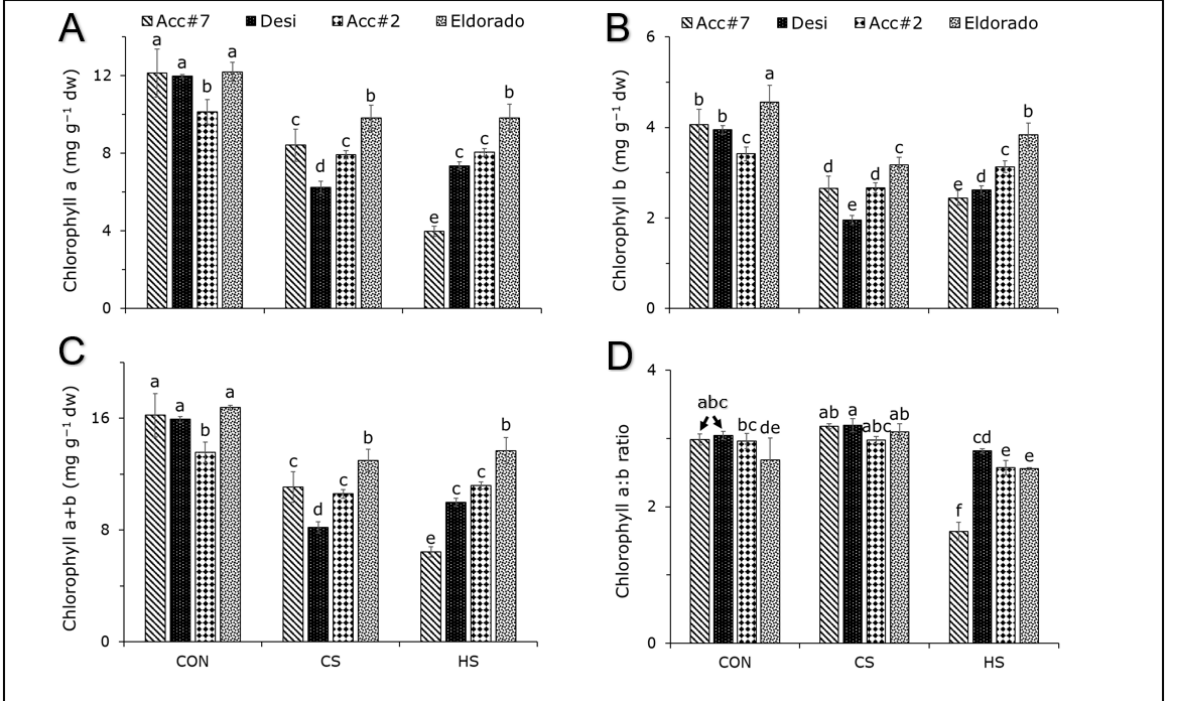
Figure 3. ( A ) Chlorophyll a (Chl. a), ( B ) chlorophyll b (Chl. b), ( C ) chlorophyll a+b (Chl. a+b) and ( D ) chlorophyll a:b ratio (Chl. a:b ratio) in the second fully expanded top leaves of four chickpea genotypes under the treatments for 3 days. “CON”, 25/20 ◦ C day/night; “CS”, 8/4 ◦ C day/night; “HS”, 38/33 ◦ C day/night. The data represent average values ± SD ( n = 3). Different small letters above the bars indicate significant differences ( p < 0.05). The arrows are indicating that the letters abc belongs to Acc#7 and Desi at control conditions.